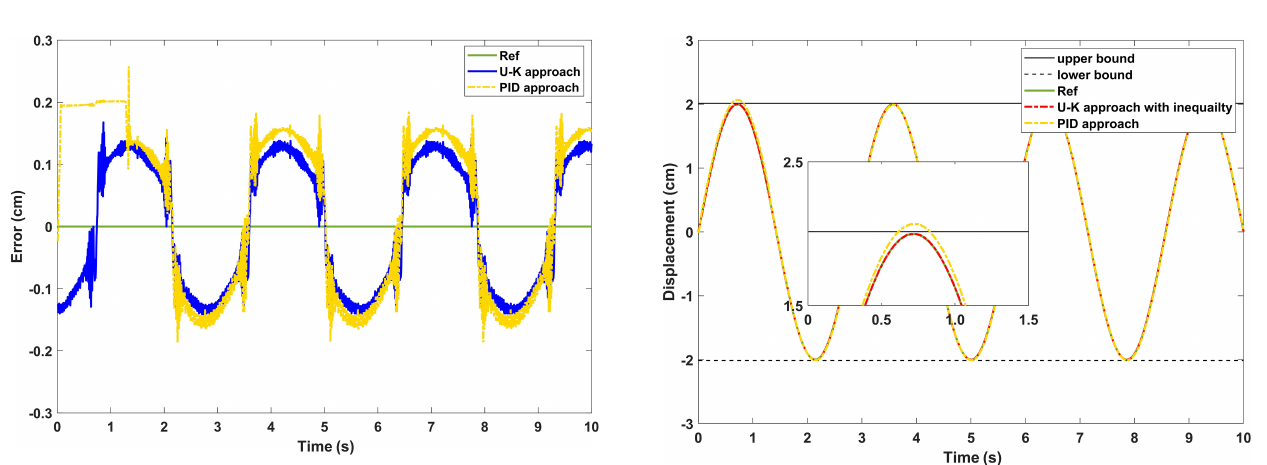
Figure 16. The experimental results of the steady-state perfor- mance of U–K with the inequality constraint and PID.